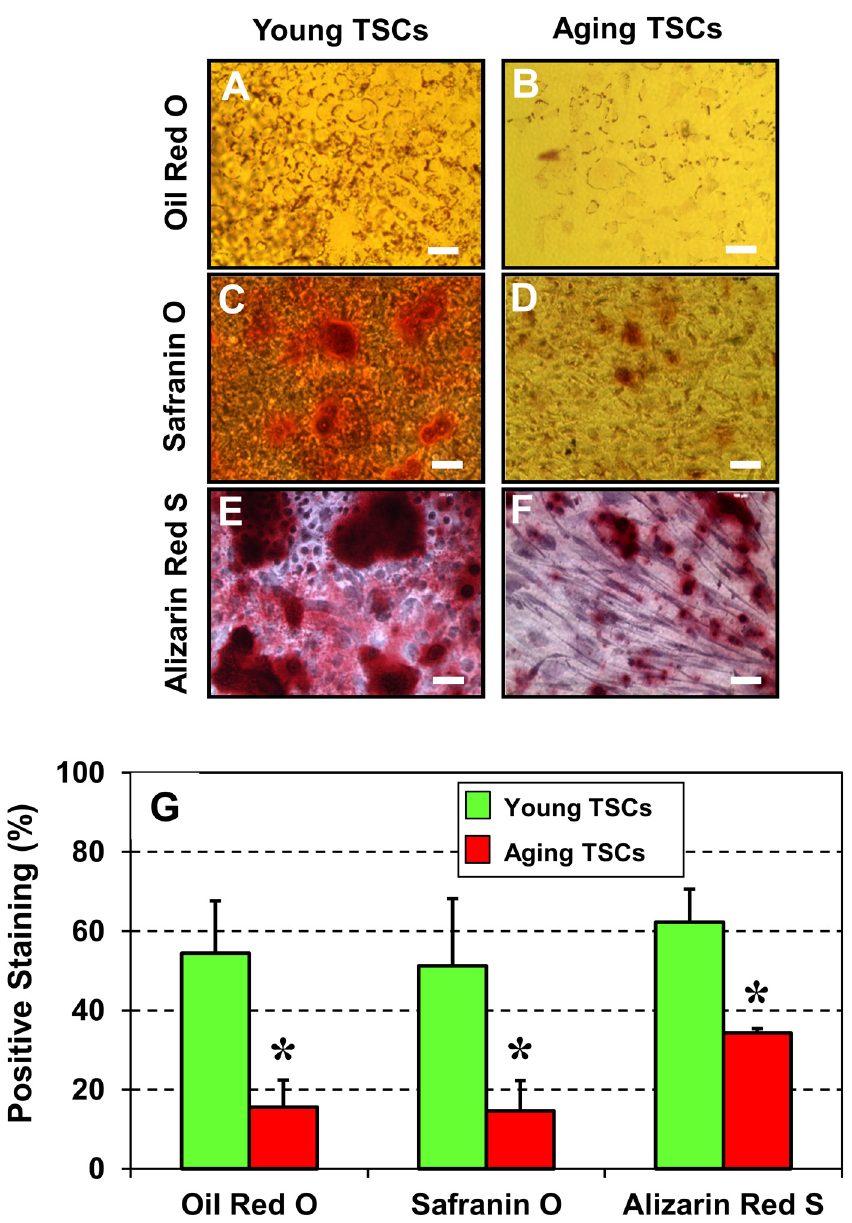
Fig 4. Cytochemical analysis of the non-tenocyte differentiation of TSCs from young (2.5 months) and aging (9 months) mice (G-L). TSCs were analyzed for their ability to undergo multi-differentiation by incubating in specific differentiation induction media and staining with Oil Red O ( G , H ), Safranin O ( I , J ) and Alizarin Red S ( K , L ). Evidently, young TSCs in culture differentiated more extensively into adipocytes ( G ), chondrocytes ( I ), osteocytes ( K ) than their counterparts — aging TSCs ( H , J , L ). Semi-quantitation ( M ) of the positively stained regions was performed by analyzing 12 different images of each tendon section. Data are mean ± SD, and * P < 0.05, compared to young